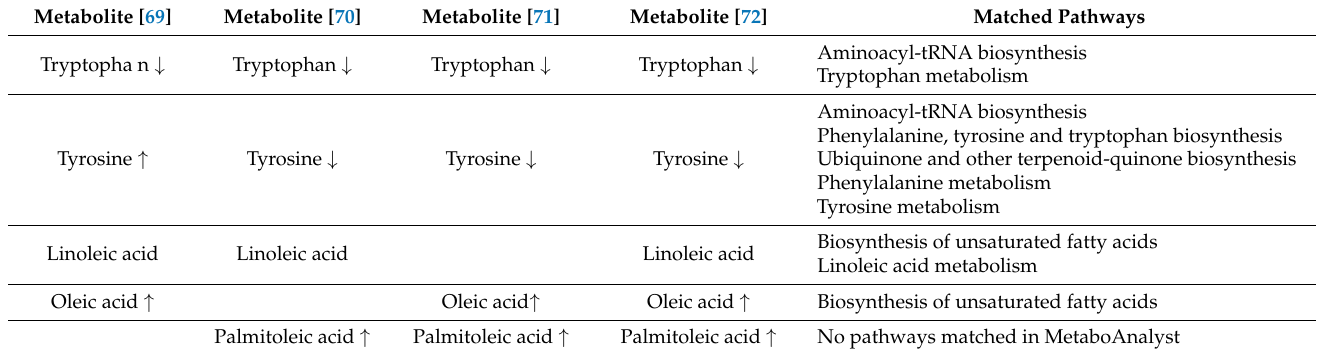
Table 6. Metabolites reported by at least three out of four studies listed in Table S1 and their associated metabolic pathways. Metabolite